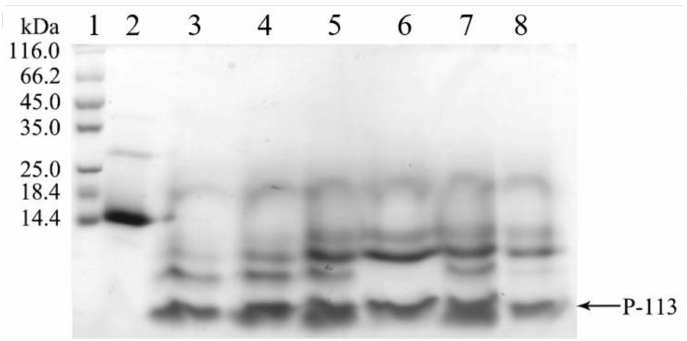
Figure 4. SDS-PAGE analysis of the cleavage of hG31P-P-113 at different times. Lanes 1 : protein molecular weight markers; Lane 2 – 8 : 0~6 h after CNBr cleavage. Proteins were stained with Coomassie brilliant blue.